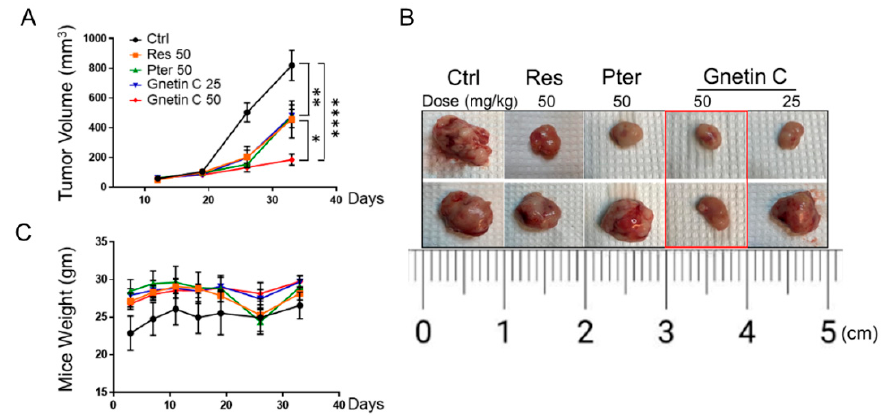
Figure 4. Gnetin C reduces tumor growth in PC3M-Luc s.c. xenografts. ( A ) Male nude mice were injected s.c. with 10 6 PC3M-Luc cells. Treatment (i.p.) with compounds started at day 19 when tumor volume was ~200 mm 3 . Tumor growth was measured using a digital caliper, twice a week. Significant tumor volume reduction was detected in all compound-treated vs. Ctrl group starting at day 25 with profound effect of Gnetin C at the high dose (50 mg/kg bw) at the endpoint. The mean ± SEM are shown. * p < 0.05; ** p < 0.01; **** p < 0.0001 (two-way ANOVA). ( B ) Representative images of two excised tumors from each treatment group are shown: Gnetin C in 50 mg/kg bw dose had firm inhibitory effect. ( C ) Average body weights of Ctrl and compound-treated groups during the study ( n = 7/group).